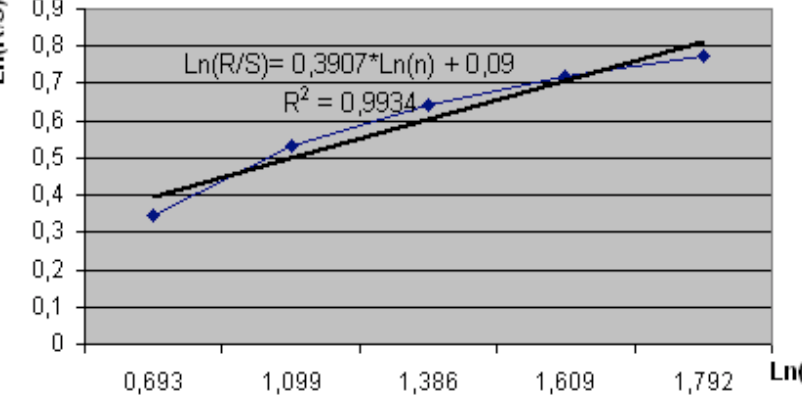
Fig. 2. The dependence of Ln(R/S) from Ln(n) (the natural logarithm of the mean value of R/S from the natural logarithm of the length of the adjacent period n) of the Cooper test of the experimental